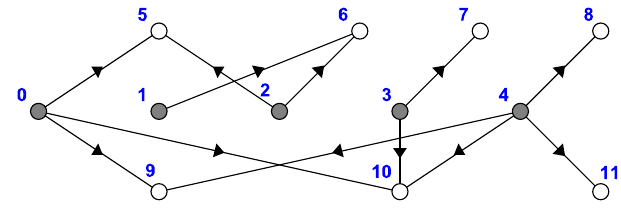
Figure 4: Example bipartite digraph having only sources and sinks.